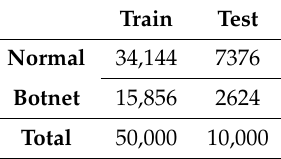
Table 1. Distribution of train and test samples across normal and botnet